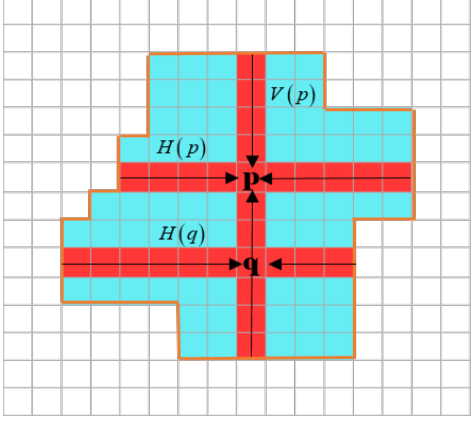
Figure 4. The cross-based support region construction for cost aggregation.